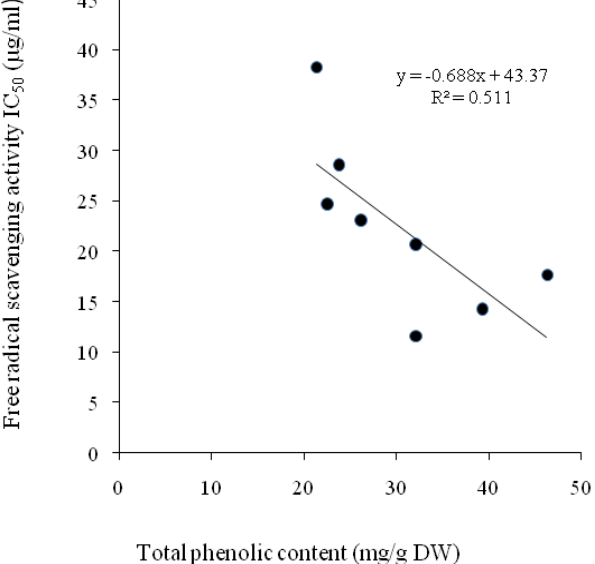
Fig. 2. Correlation of free radical scavenging activity (Y) versus total phenolic content (X) of eight Lamiaceae plants of Ma- nipur